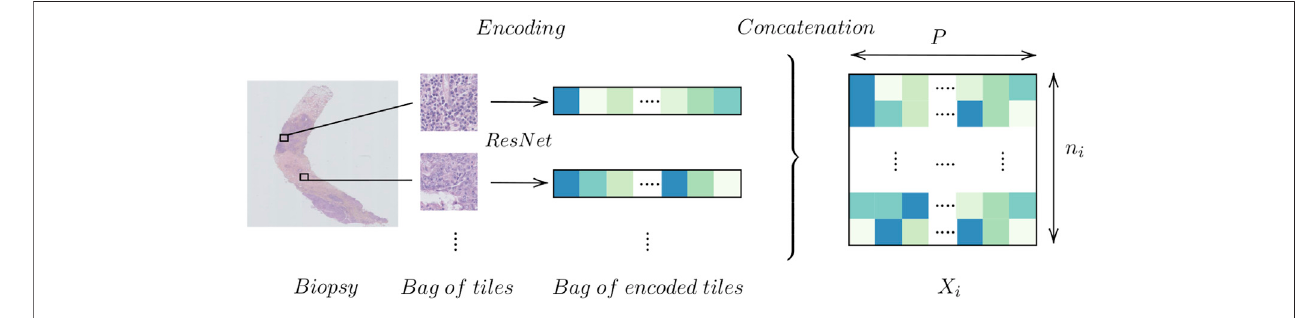
FIGURE 2 | Encoding a biopsy.